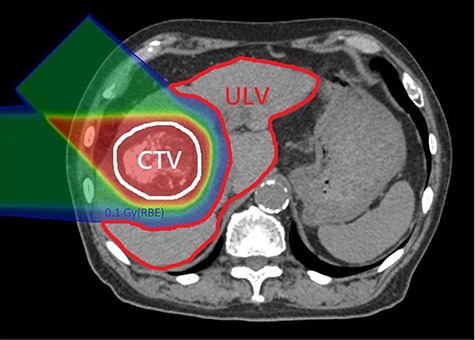
ULV preservation rate is defined as the ratio of ULV (red line) receiving a total dose <0.1 Gy(RBE) during PBT, to NLV, which is the whole liver volume minus CTV (white line).